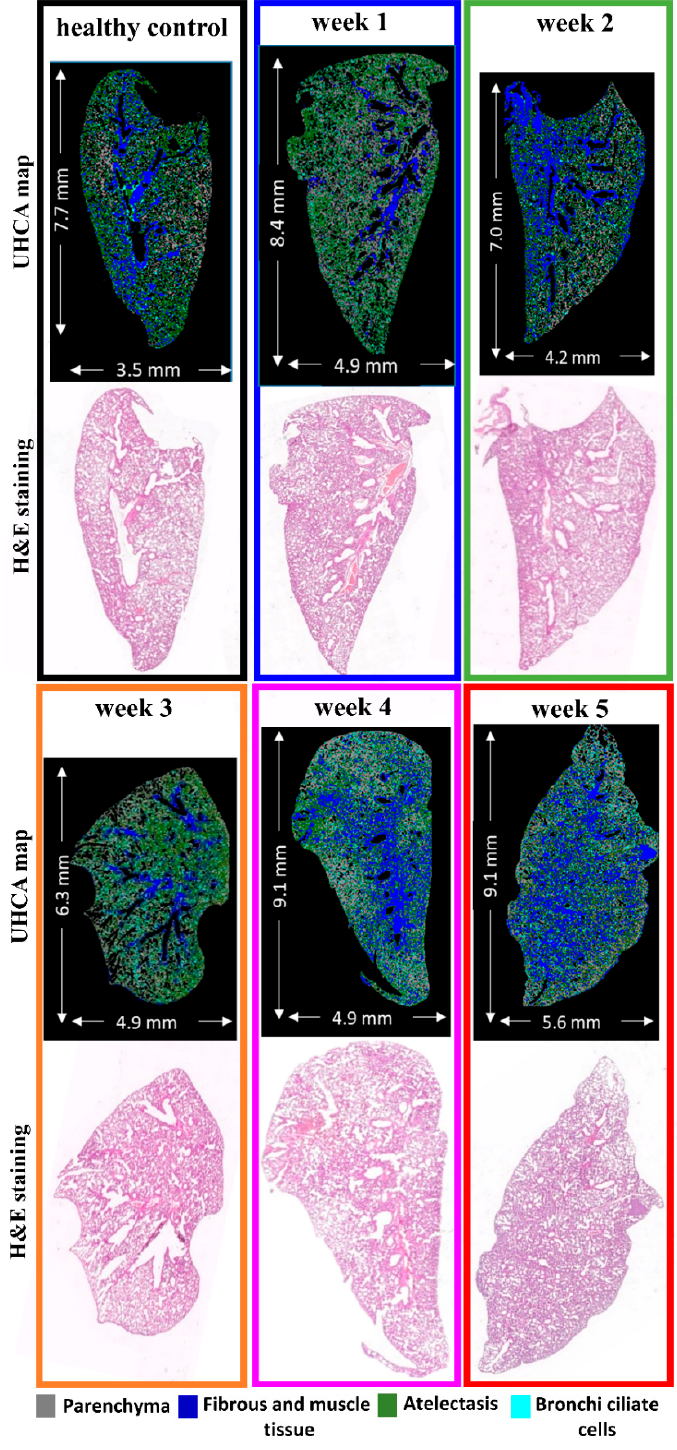
Figure 1. Comparison of false-color unsupervised hierarchical cluster analysis (UHCA) maps with hematoxylin and eosin (H&E) microphotographs collected from lung cross-sections. UHCA classification of the most abundant tissue types in lungs: parenchyma (grey), atelectasis (green), fibrous / muscular tissue (blue), and bronchi ciliated cells (aqua) corresponds to tissue structure observed in the H&E images. Magnified microphotographs after H&E staining with marked tissue types are shown in Figure S2 in Supplementary Materials.